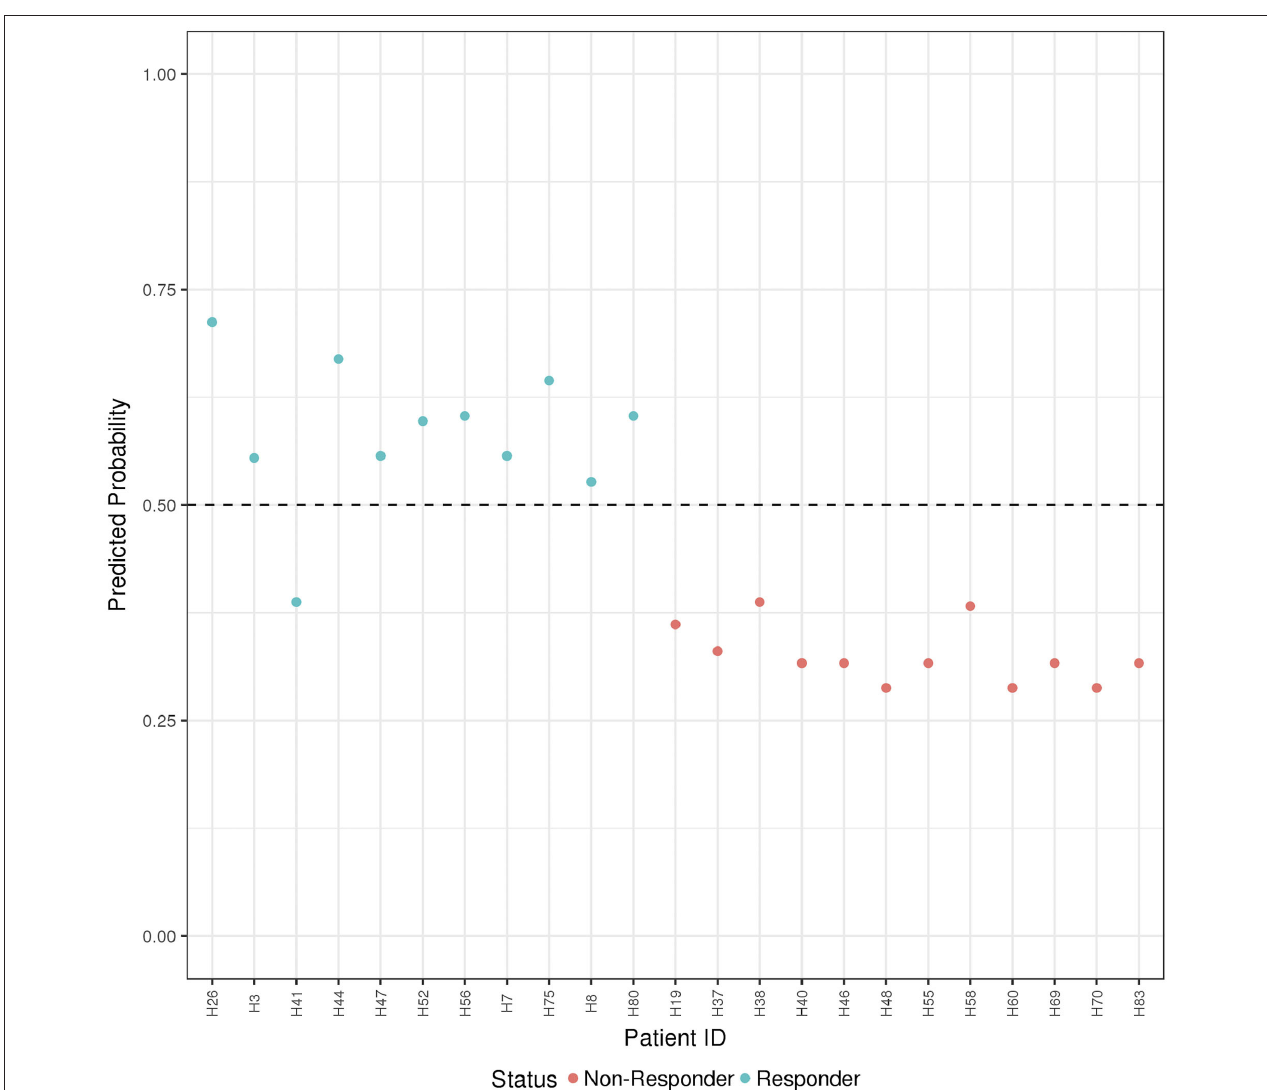
FIGURE 4 | ADA Boost Probability Scores (B and T Cells): the combined prediction score between B and T cells are shown for each patient (the non-responder in red and responder in blue). If the probability is > 0.50 the patient has been classified as responder, on the contrary if < 0.50.